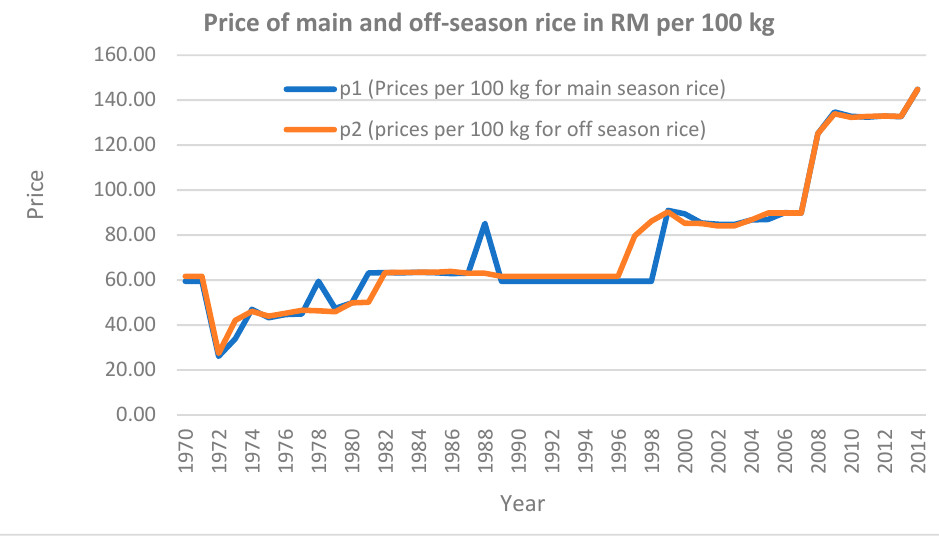
Figure 4. Prices of main- and off-season rice, 1970–2014. The average annual rainfall of Malaysia in the MADA area was 2106.966 mm with a standard deviation of 196.2435 mm. However, the hottest (lowest rainfall) year with a minimum rainfall of 1652.08 mm was recorded in 1980, whereas the coldest (maximum rainfall) year was in 1974 with a maximum rainfall of 2487.456 mm, as can be seen in Figure 5. Correlation among the selected variables given in Table 2 shows positive as well as negative associations among different variables. It is clear that the output of season 1 (main-season) rice was highly-to-moderately and positively correlated with the price of paddy rice in season 1 as well as in season 2 (off-season). There was a moderate correlation between the area under season 1 rice and output of season 1 rice. Similarly, the price of season 1 rice was moderately and positively correlated with the output of off-season rice, as was true in case of price of season 2